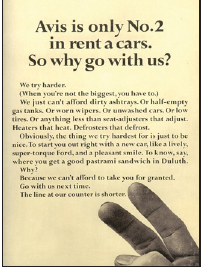
Figure 2: Being different, trying harder– Avis print ad. (DDB